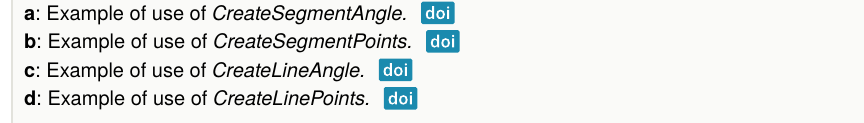
Examples of use of the speci fi c functions for lines and segments creation. The coincidence in the outputs is due to the choice of equivalent parameters, which are visible in their corresponding fi